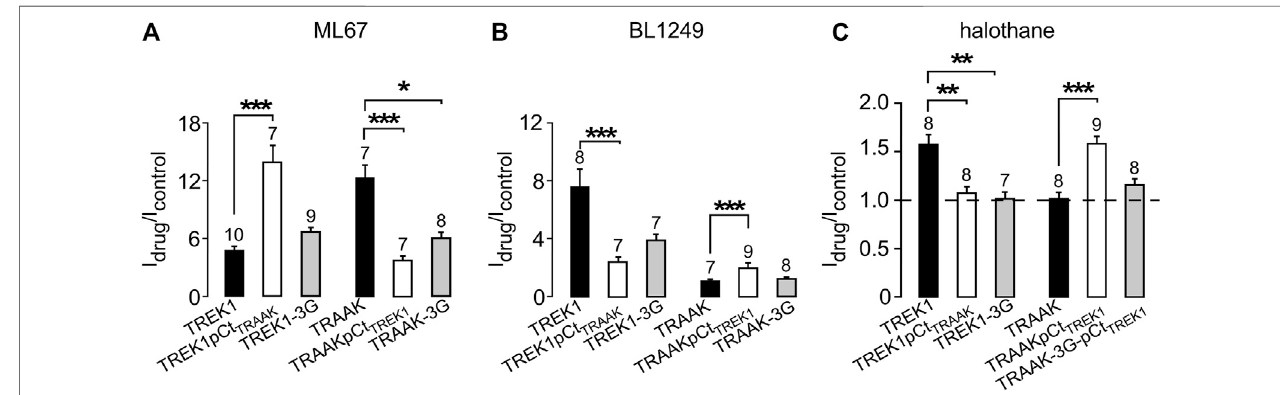
FIGURE 5 | Proximal C-ter domain (pCt) modulates channel sensitivity to drugs. (A, B, C) Fraction of thecurrents sensitive to ML67 (100 μ M) (A) , BL1249 (10 μ M) (B) and halothane (1 mM), as recorded in Figures 2 – 4 . (C) . Data are presented as mean ± SEM, the number of cells is indicated, p p < 0.05, pp p < 0.01, ppp p < 0.001 (Kruskal